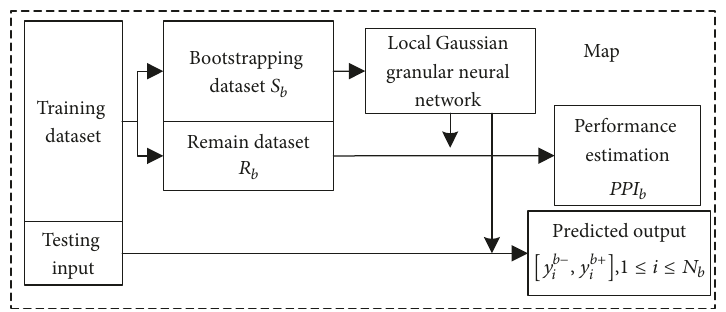
Figure 3: The processing procedure of the Map task.